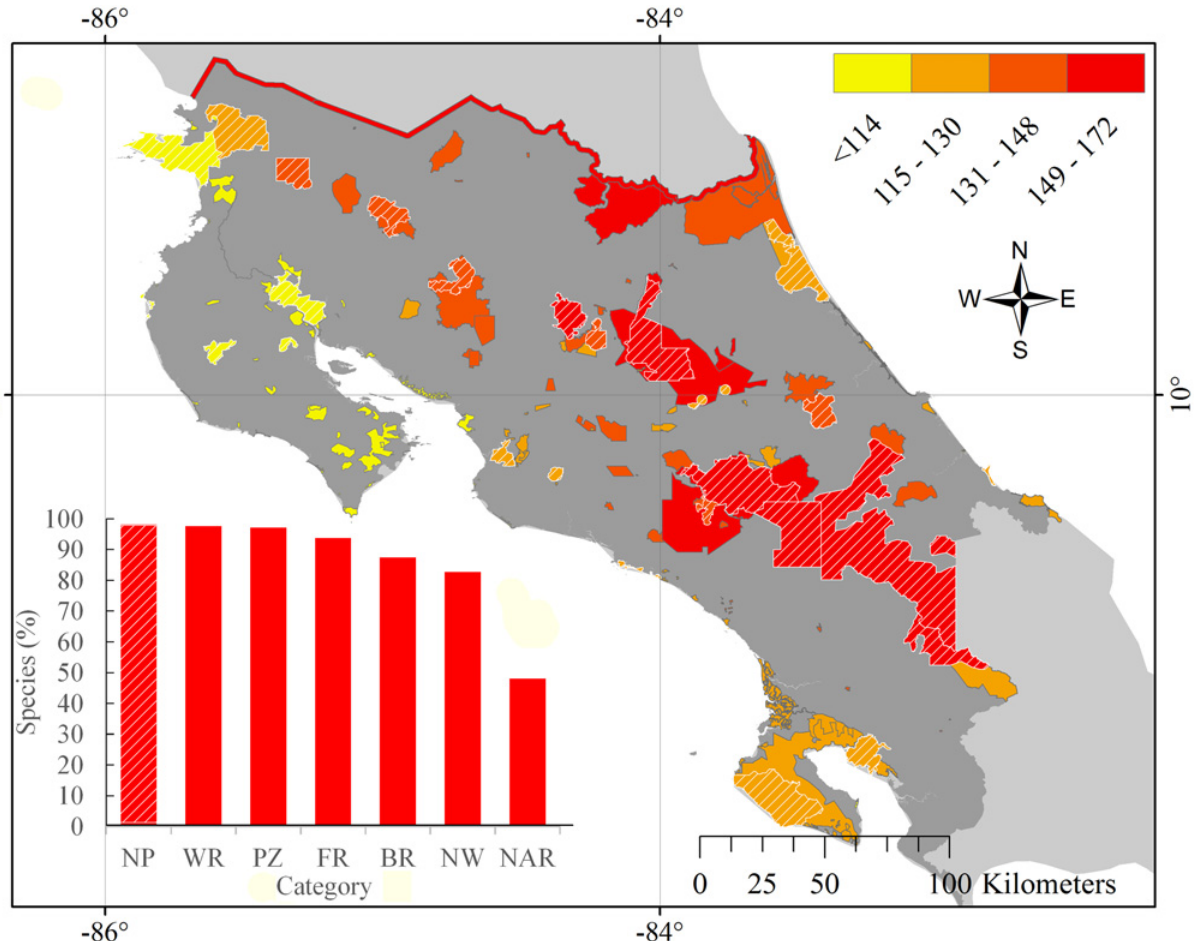
Fig 3. Number of mammal species by protected area and category in Costa Rica. The color scale at the top right indicates the number of species on each protected area. Protected areas with diagonal lines are National Parks. The inset figure indicates the percentage of mammal species in each protected area category (National Parks (NP), Wildlife Refuges (WR), Protected Zones (PZ), Forest Reserves (FR), Biological Reserves (BR), National Wetlands (NW) and Natural Absolute Reserves (NAR)).